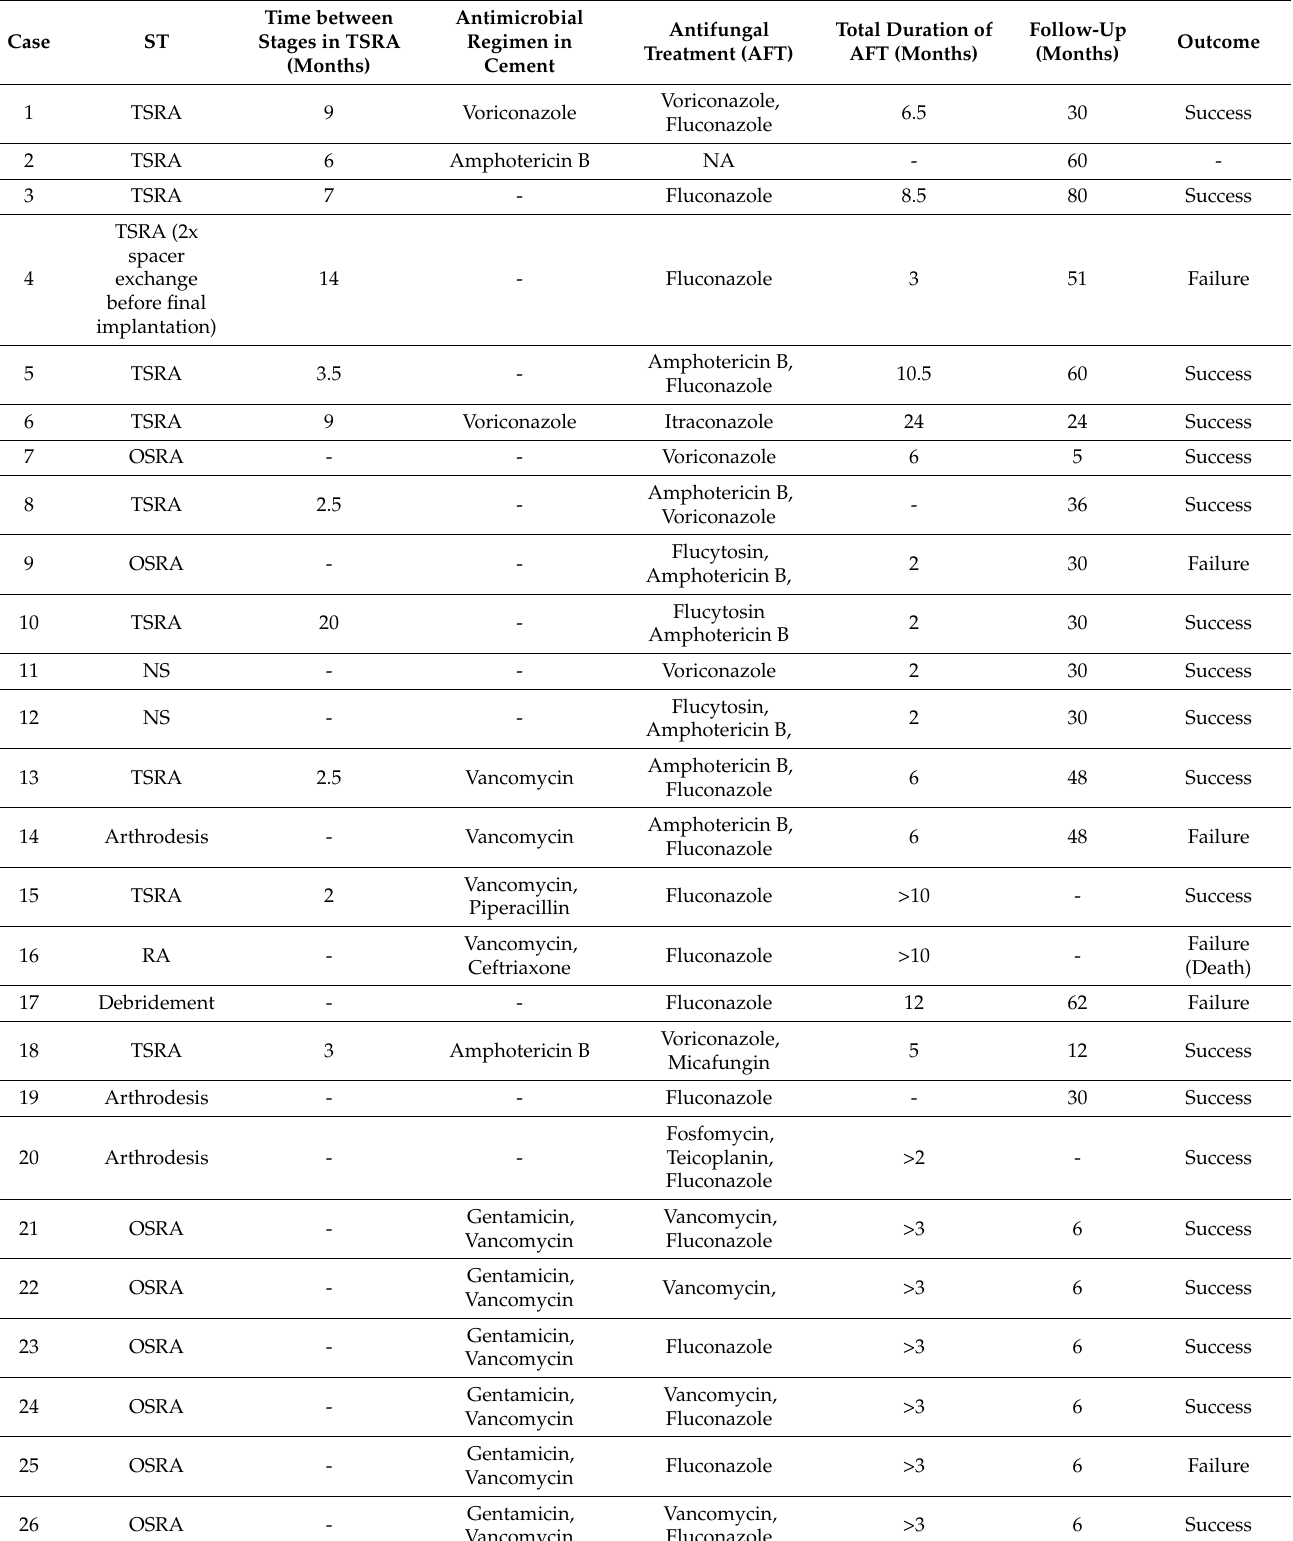
Table 3. Surgical and antifungal treatment, follow-up, and infection outcome of the reported cases. ST: Surgical Treatment, TSRA: two-stage revision arthroplasty, OSRA: one-stage revision arthroplasty, AFT: antifungal treatment, LS: lifelong suppression, NS: no surgery, RA: resection arthroplasty,